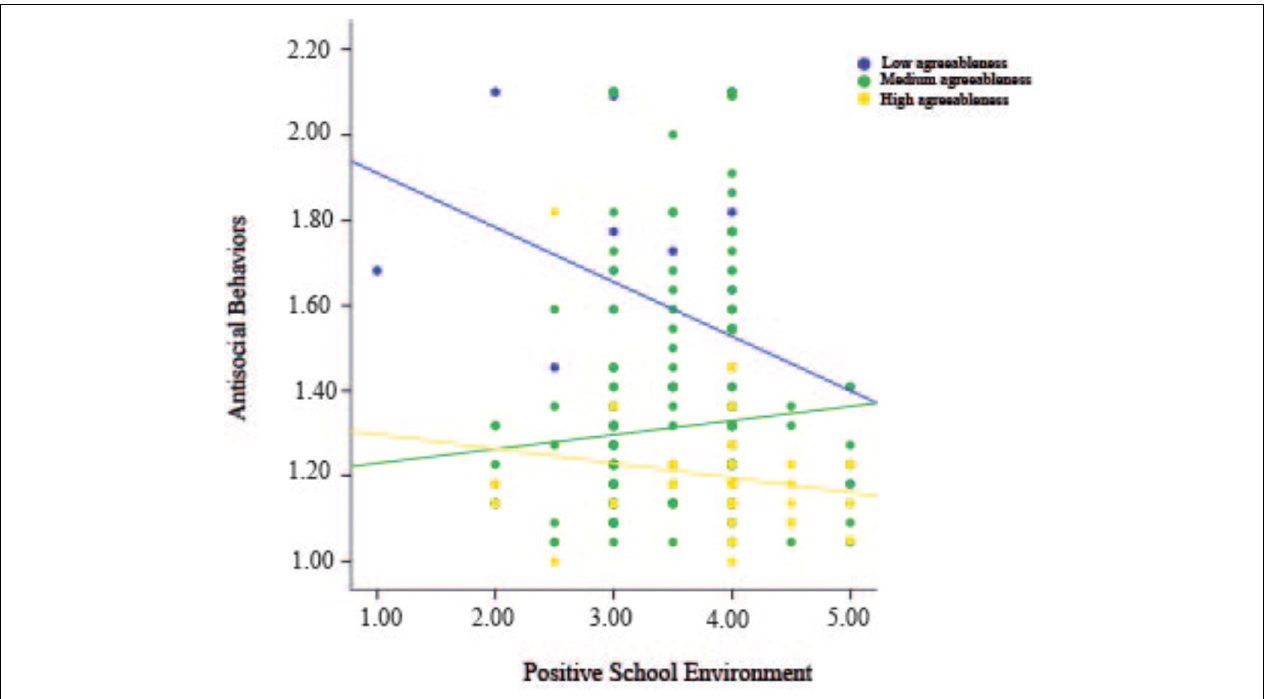
FIGURE 3 | Regression model measuring the moderating role of agreeableness between positive environment and antisocial behaviors in Mexican university students. A significant interaction between agreeableness and positive environment was found ( R 2 = 0.41, (cid:49) R 2 = 0.01, b = 0.08, p =